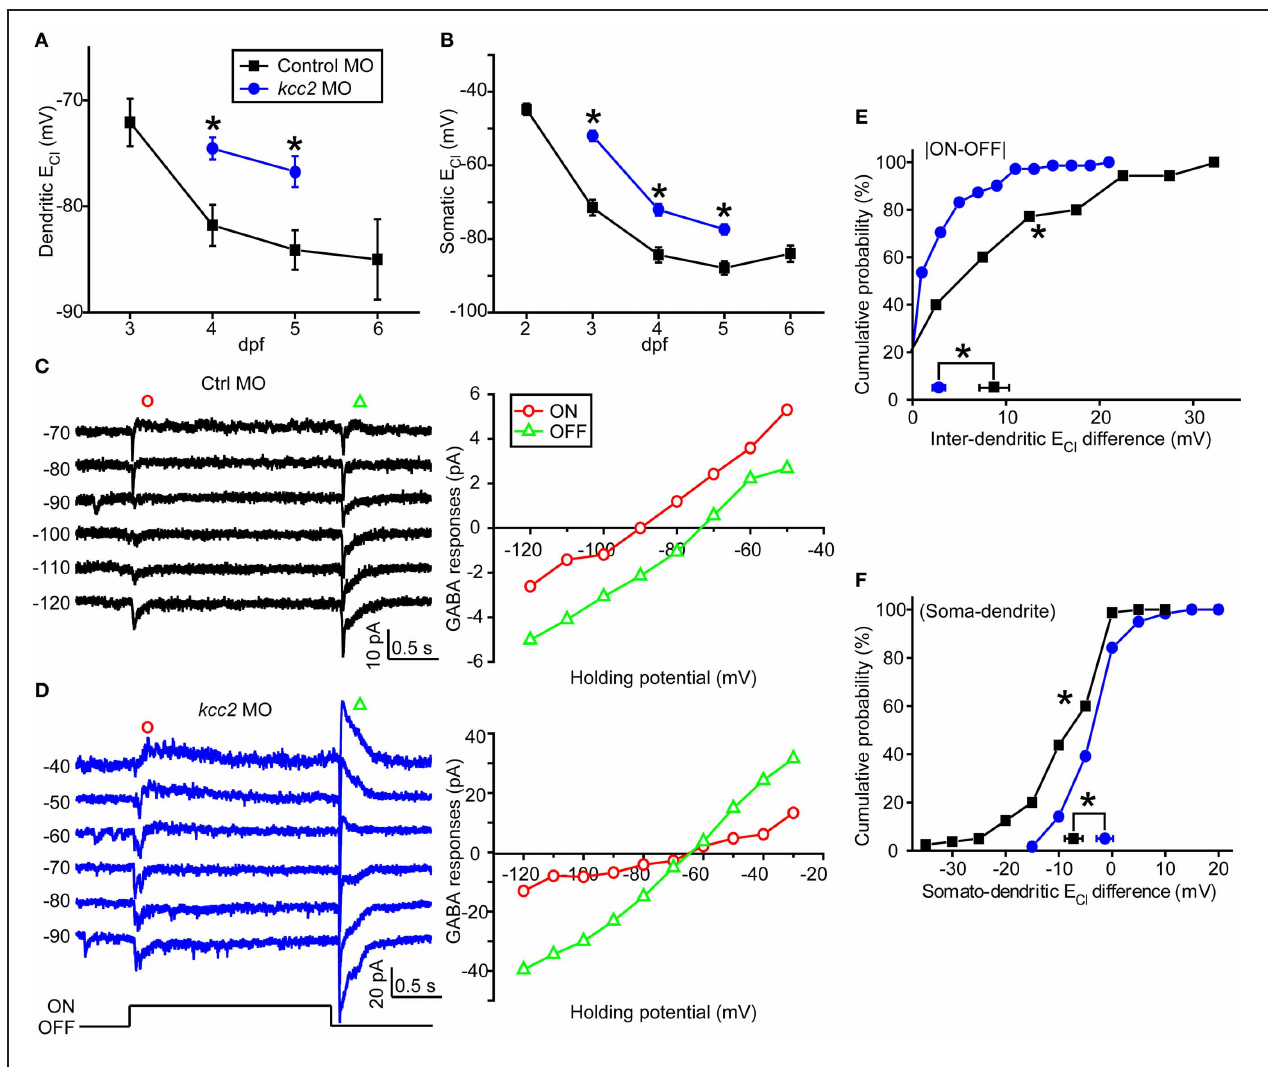
of the late-phase components of light responses. (E,F) Cumulative probability of inter-dendritic (E) and somato-dendritic (F) E Cl differences in control ( n = 35 cells) and kcc2 morphants ( n = 71 cells). The symbols near the X-axis represent the mean E Cl differences. ∗ P < 0 . 01, Kolmogorov–Smirnov test. The values are represented as mean ±